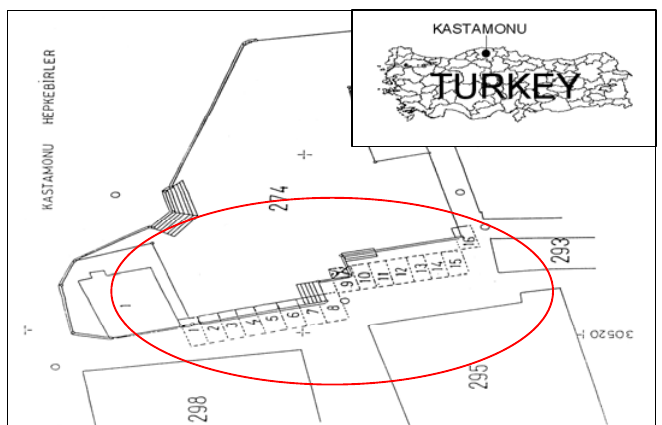
Figure 5. Description of shops built under Mutaflar